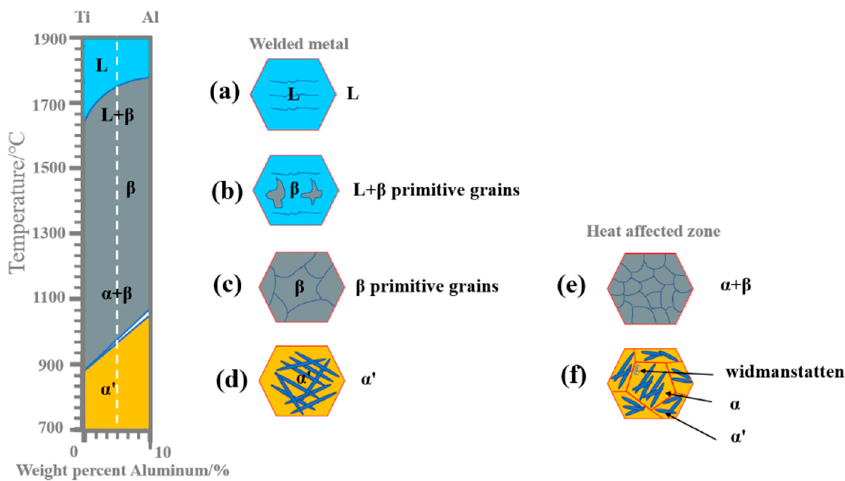
Figure 13. Microstructure evolution of Ti64 titanium alloy welded joint: WM: ( a ) L; ( b ) L + β ; ( c ) β ; ( d ) α′ ; HAZ: ( e ) α + β ; ( f ) α + widmanstatten + α′ .